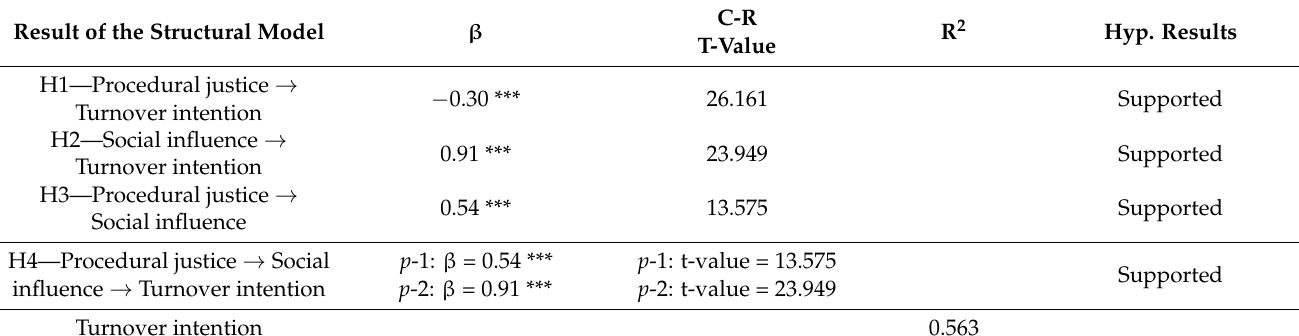
Table 3. Result of the structural model (developed by